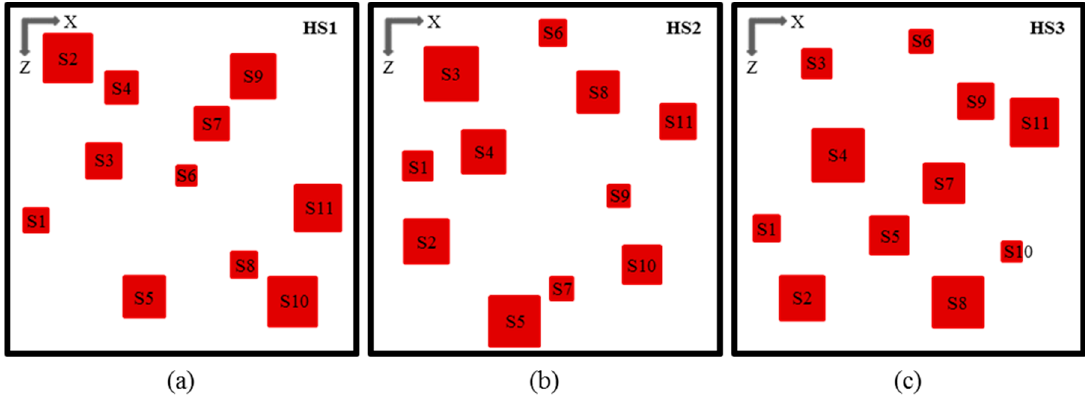
Figure 2. Hotspot layout schemes: ( a ) HS1; ( b ) HS2; and ( c ) HS3. Table 1. Microchannel dimensions (mm).